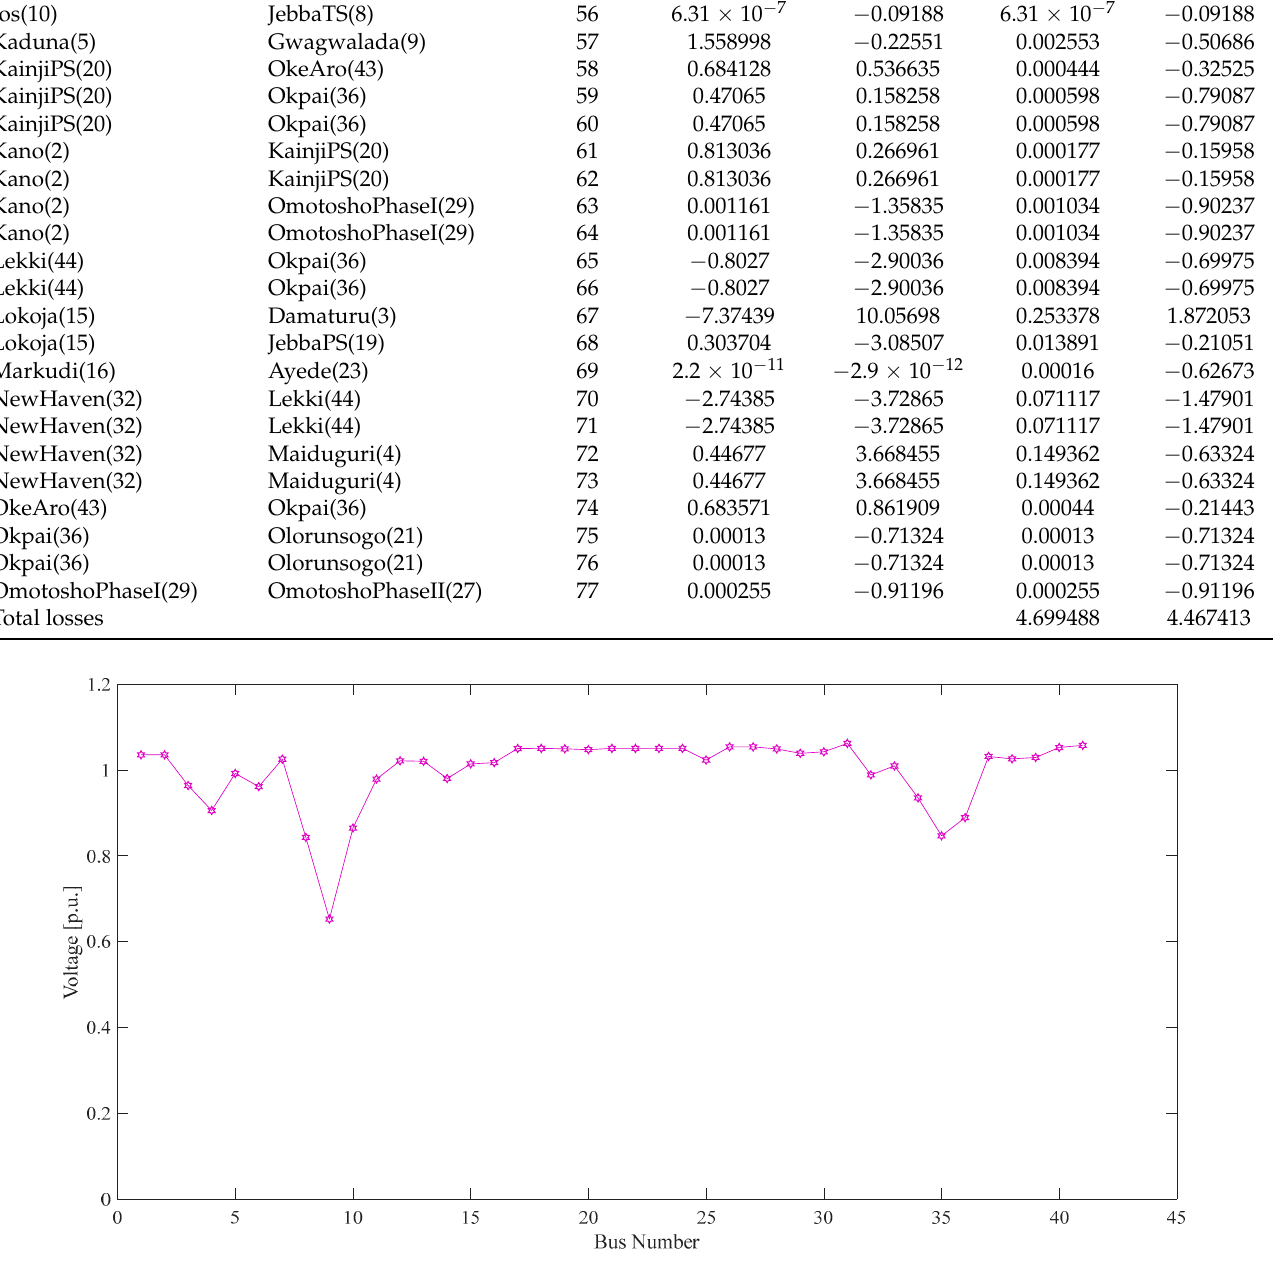
Figure 4. Voltage profile of the uncompensated Nigerian 41 bus transmission network.